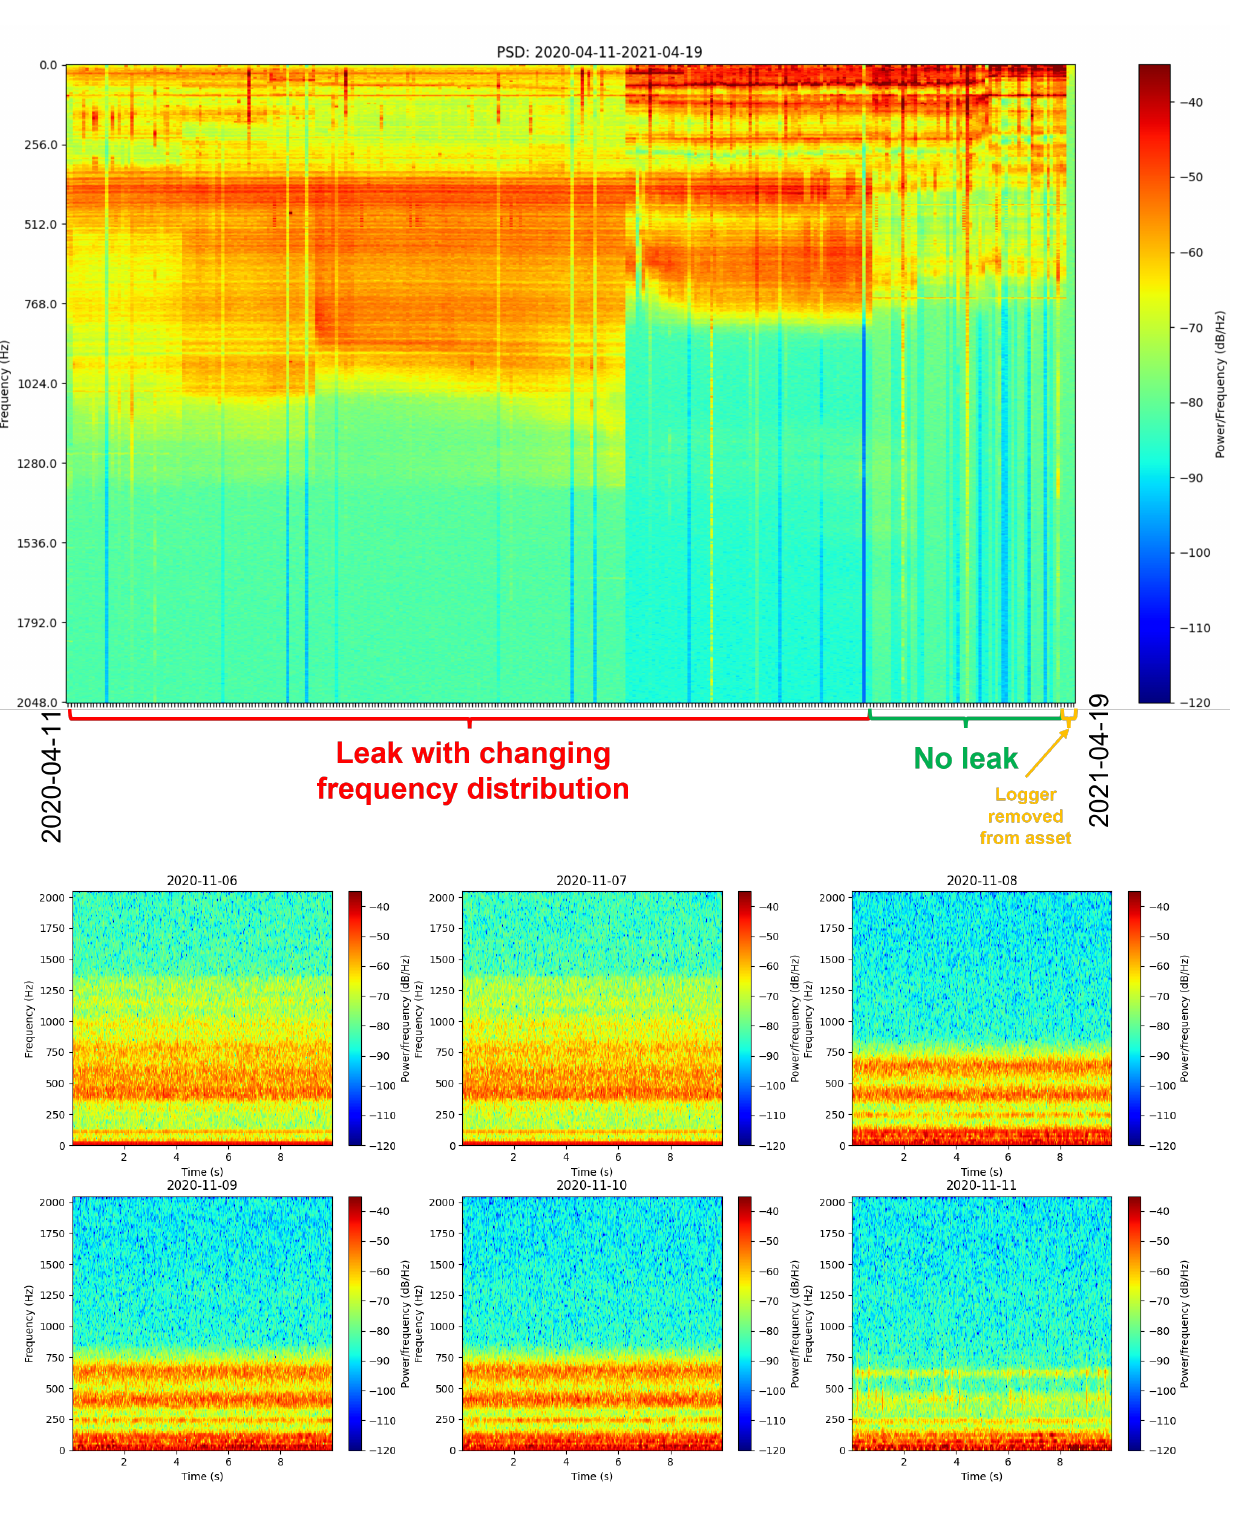
Figure 7. Leaking main tap-changing frequency distribution is visible in the PSD ( top ) and spectro- grams ( bottom ) from consecutive days. The logger was situated approximately 59 m away from the leak location, with noise being propagated along a straight section of 150 mm diameter CICL